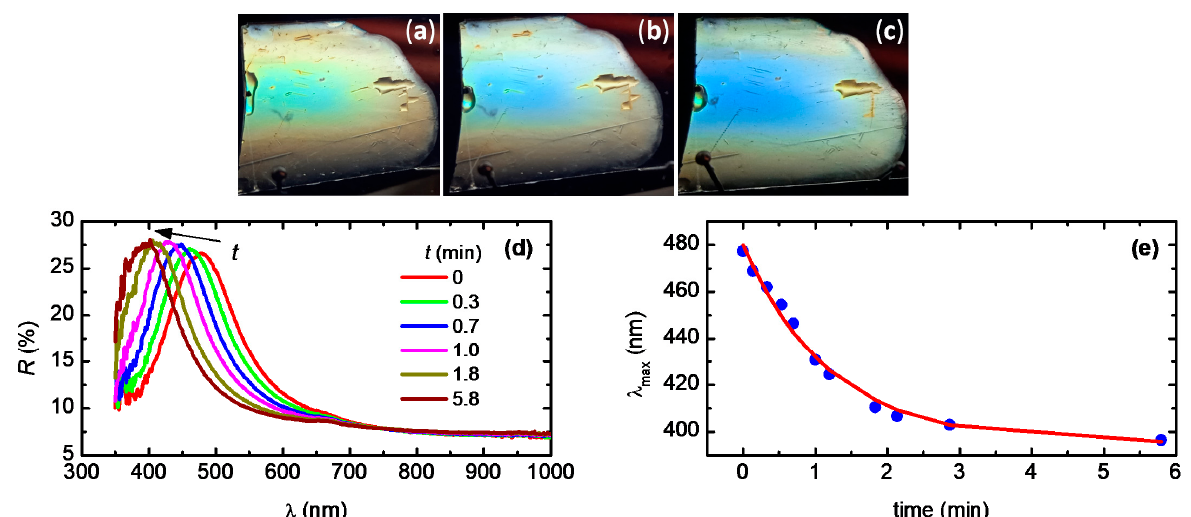
Figure 7. ( a ) Image of a CNC film after immersion in deionized water, ( b ) after 1.3 min, and ( c ) after 5.8 min. ( d ) Time- dependence of the reflectance for unpolarized incident light. ( e ) Experimental (blue circles) wavelength maxima of selective reflections as a function of drying time; the red curve corresponds to a fitted exponential decay of λ max